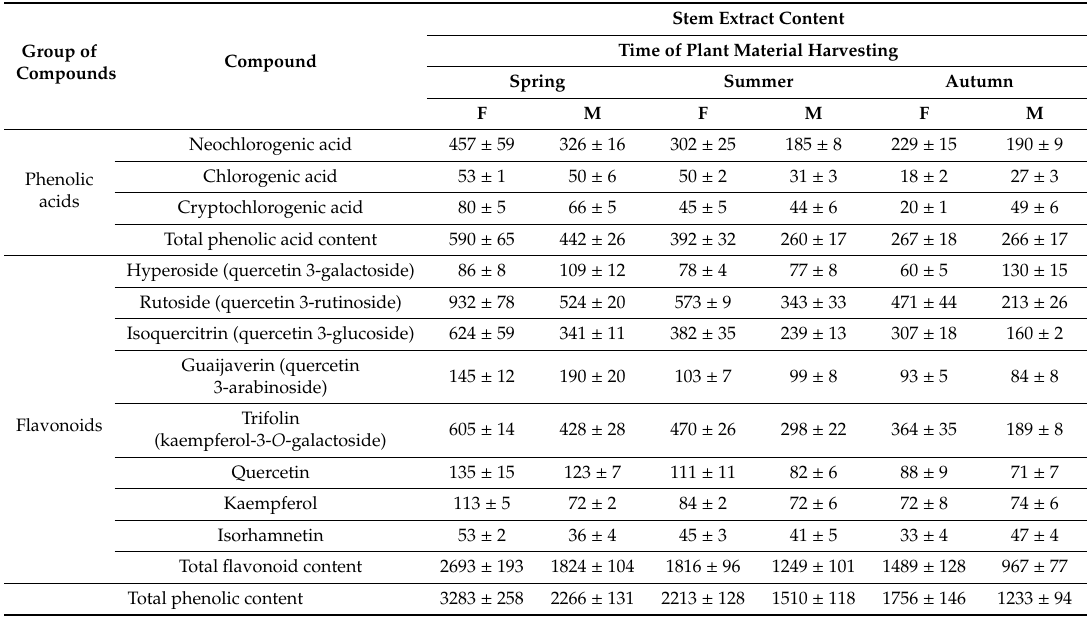
Table 3. The content (mg / 100 g DW ± SD) of main detected phenolic compounds of S. rubriflora stem extracts (F—female; M—male) ( n = 5, p < 0.05).